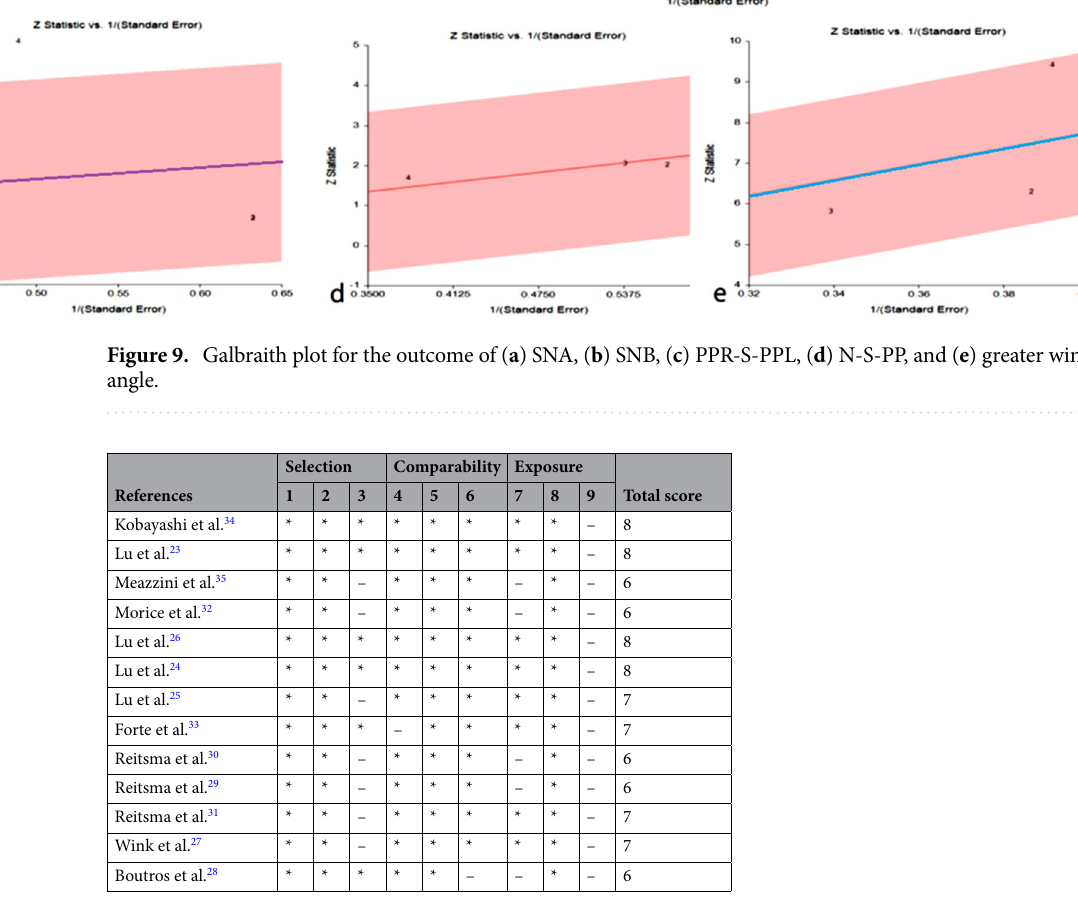
Table 4. Methodological quality assessment of the studies by Newcastle–Ottawa quality scale assessment (NOS). 1—Adequate case definition; 2—Representativeness of the cases; 3—Selections of